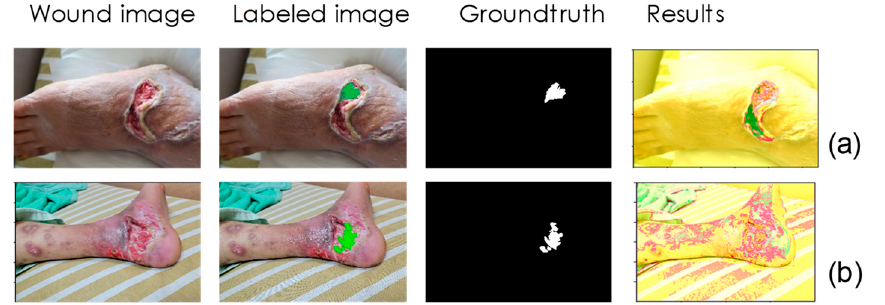
Figure 7. Other factors that cause misclassification. ( a ) Wetter tissue is more likely to reflect light when photographed, thereby affecting the detection model. ( b ) In more complex wounds, gran- ulation is not easily correctly detected due to mixing with other